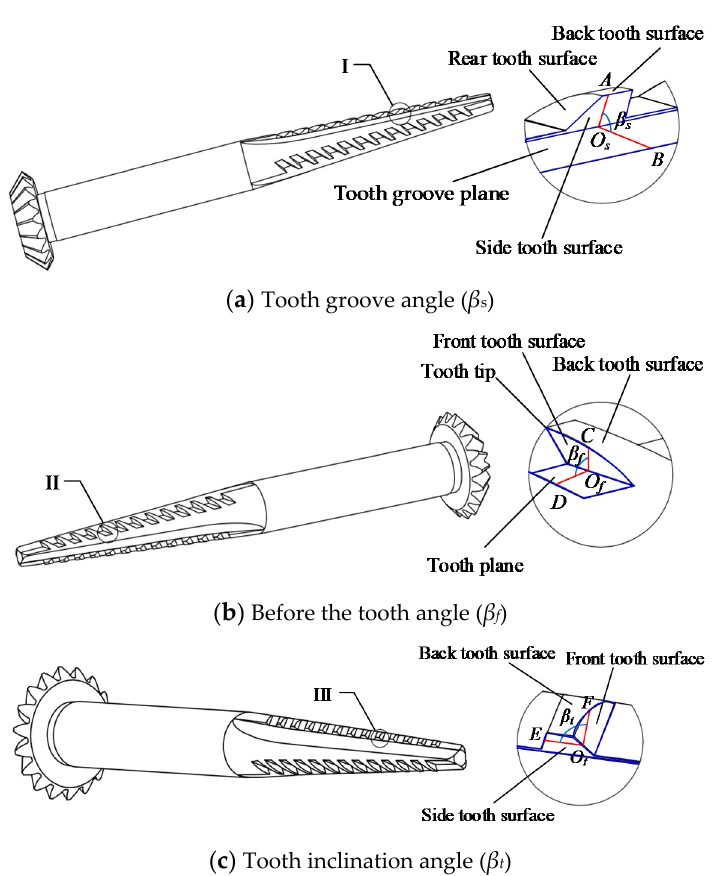
Figure 8. Schematic representation of the tooth angle division of the spindle hook.